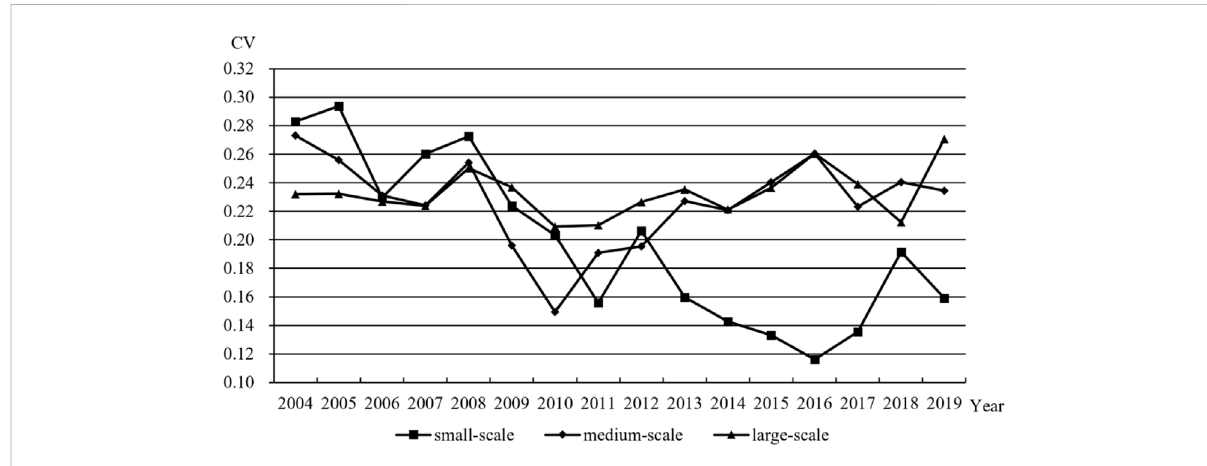
FIGURE 2 Variation coef fi cient of environmental ef fi ciency of dairy farming on different scales.